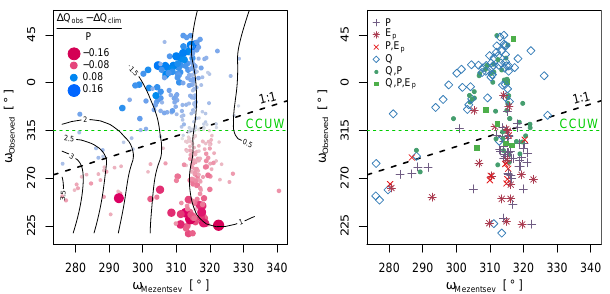
Fig. 8. Observed change direction in UW space ω = arctan (1U/1W) as a function of the theoretical change di- rection according to the Mezentsev function for all 351 MOPEX basins. In the left panel, the size and colour of the dots depict the normalised difference between observed and climatic related streamflow change. The right panel is restricted to basins with significant changes only, using the t-test classification